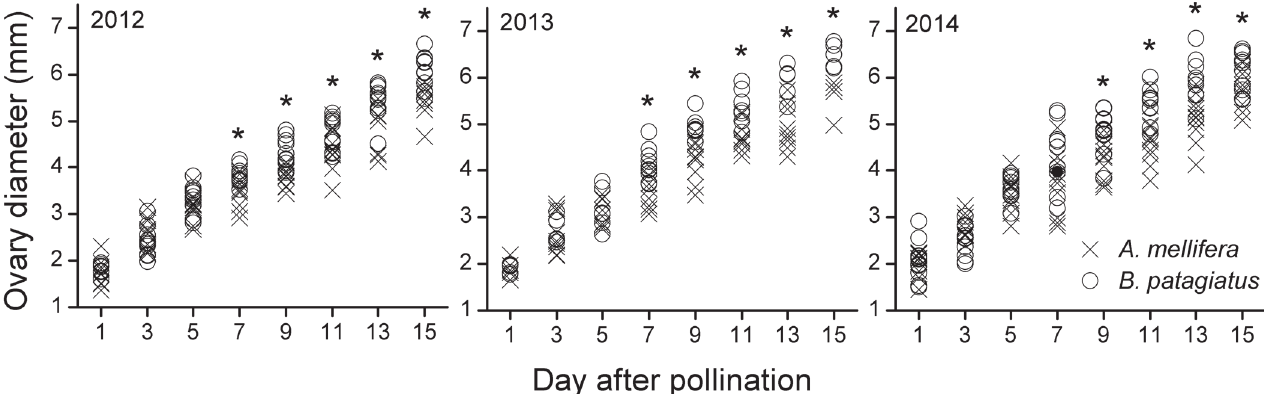
Fig 7. Early fruit development of peach under greenhouse conditions. Diameter of ovary, from pollination to 15 days later, in flowers by a single visit of A . mellifera and B . patagiatus . Single asterisks indicate significant difference at P < 0.05 by the group t